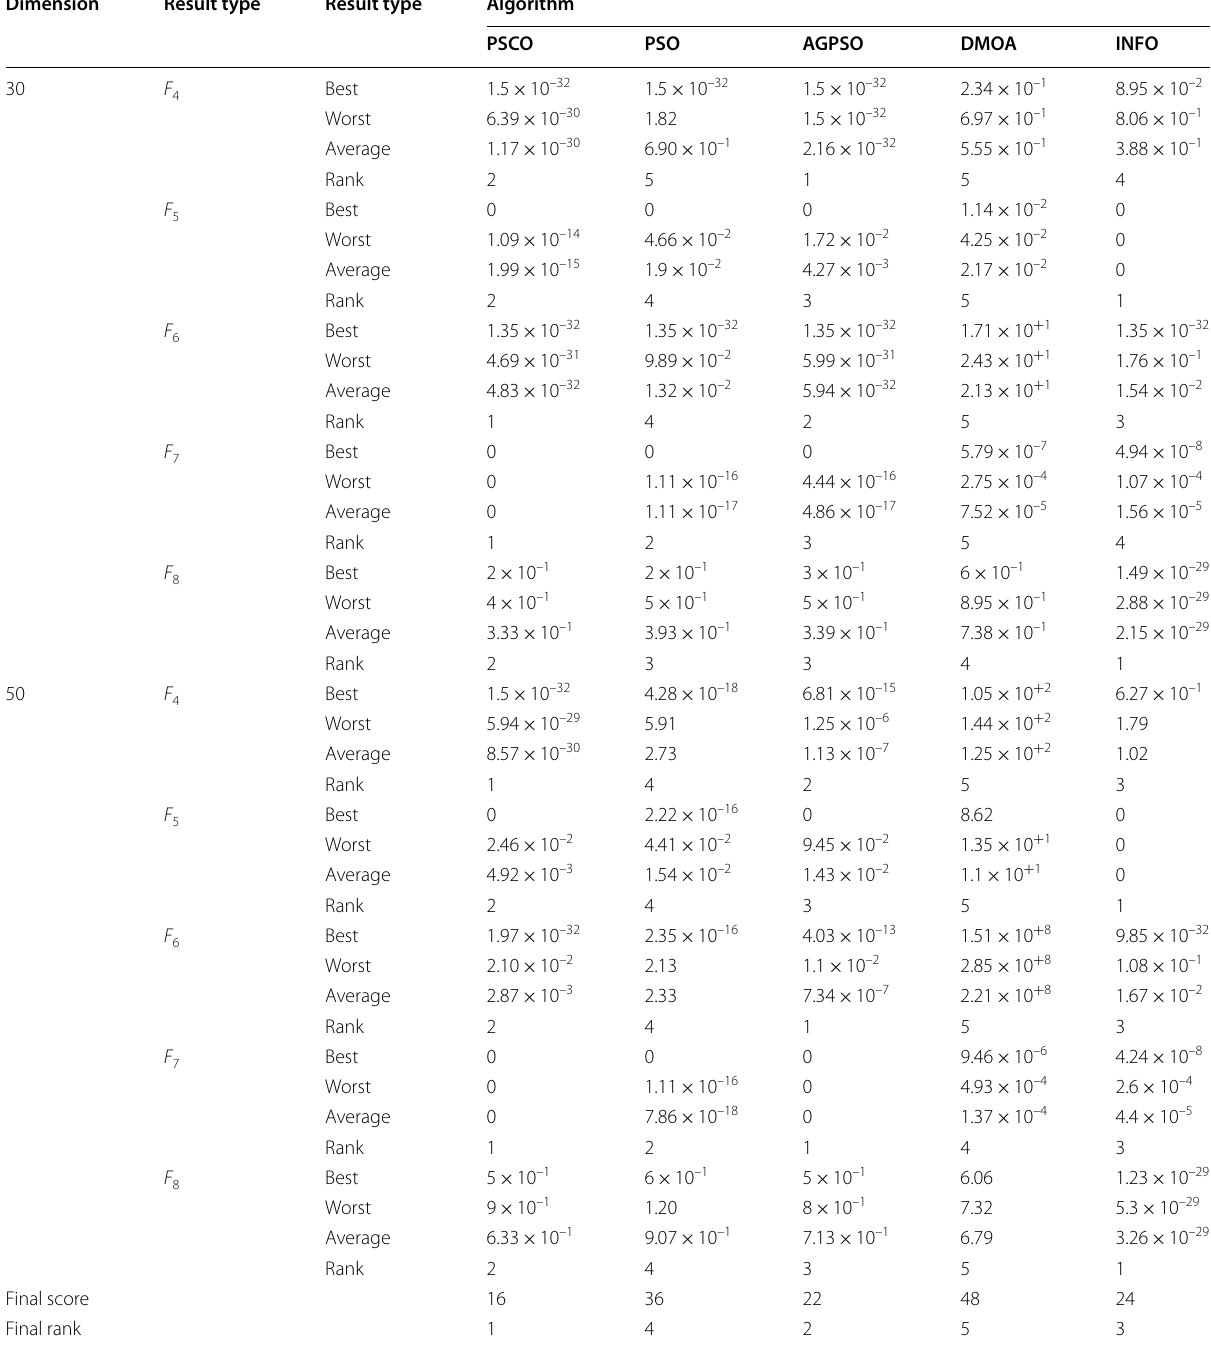
Table 5 Results obtained by the application of multimodal functions Dimension Result